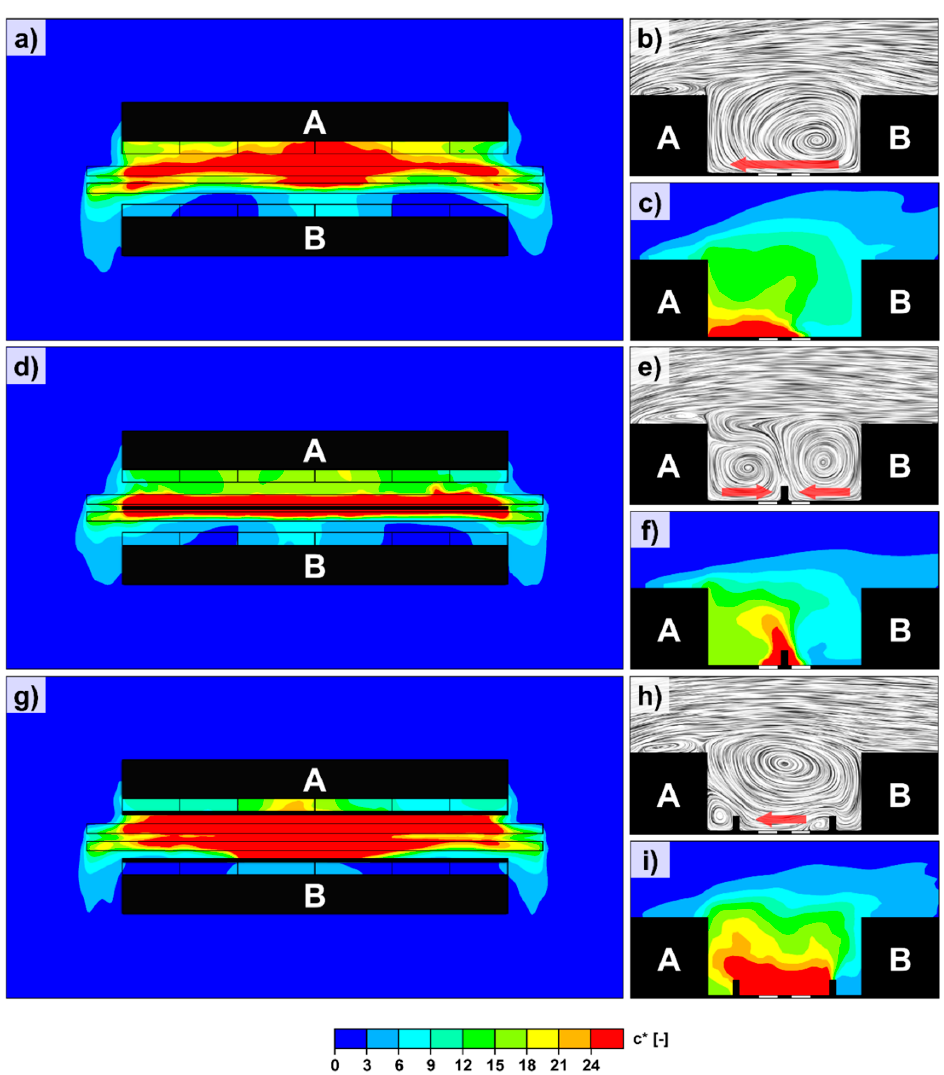
Figure 13. Time averaged streamlines and concentration contour plots. Left ( a , d , g ): typical distributions of the air pollutants at street level ( z /H = 0). Right: typical flow fields ( b , e , h ) and normalized air pollutant concentration fields ( c , f , i ) in the center area around y /H = 0. The investigated cases from top to bottom: ( a – c ) no boundary walls (NBW; reference scenario); ( d – f ) central boundary walls (CBW); ( g – i ) sidewise boundary walls (SBW). The walls are 3.48 m (0.19 H ) high in the latter cases.